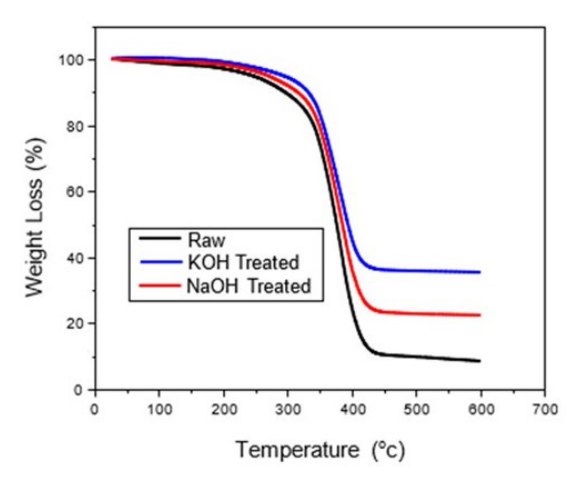
Fig. 8. TGA of Paederia Foetida